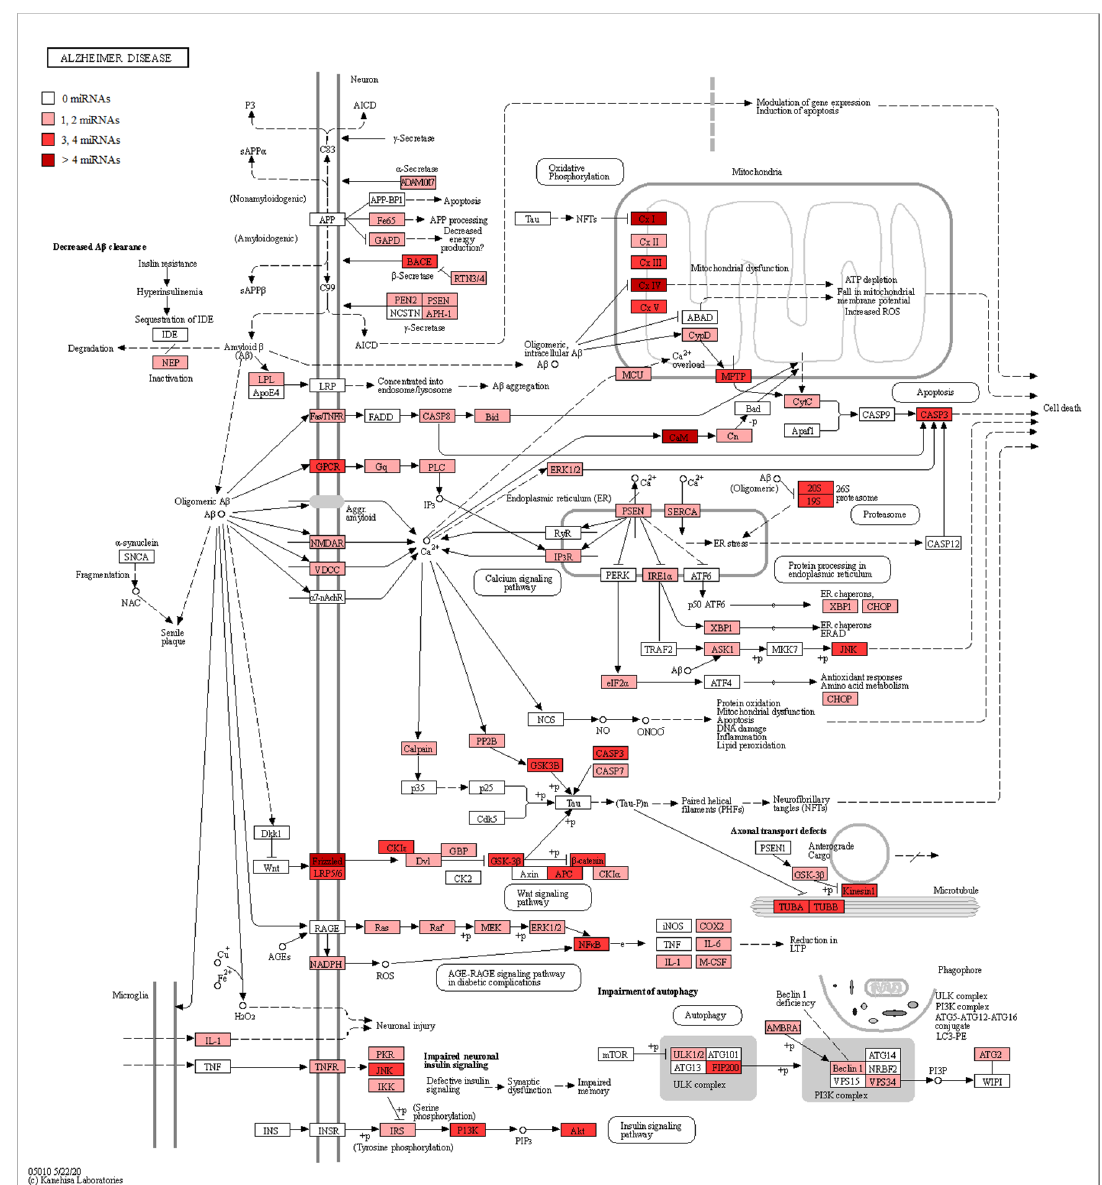
Figure 4. AD pathway with target genes of downregulated miRNAs highlighted. The schema represents the AD pathway in KEGG. The red scale represents the proteins encoded by genes known to be targets of downregulated miRNAs. A darker color, indicates a greater number of miRNAs that target the genes encoding that specific protein. If the protein is white, no miRNA targets any gene there. In particular, given that miRNAs are downregulated in our analysis, we can expect these genes to be upregulated.